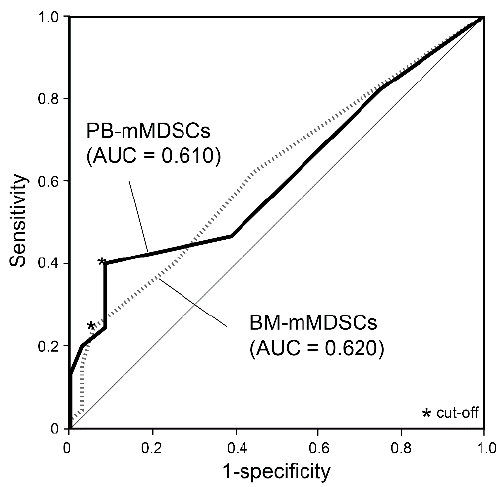
Figure 4. Receiver operating characteristic curves to determine cutoff values of monocytic myeloid- derived suppressor cells for mortality. Abbreviations: PB; peripheral blood, BM; bone marrow, mMDSCs; monocytic myeloid-derived suppressor cells.